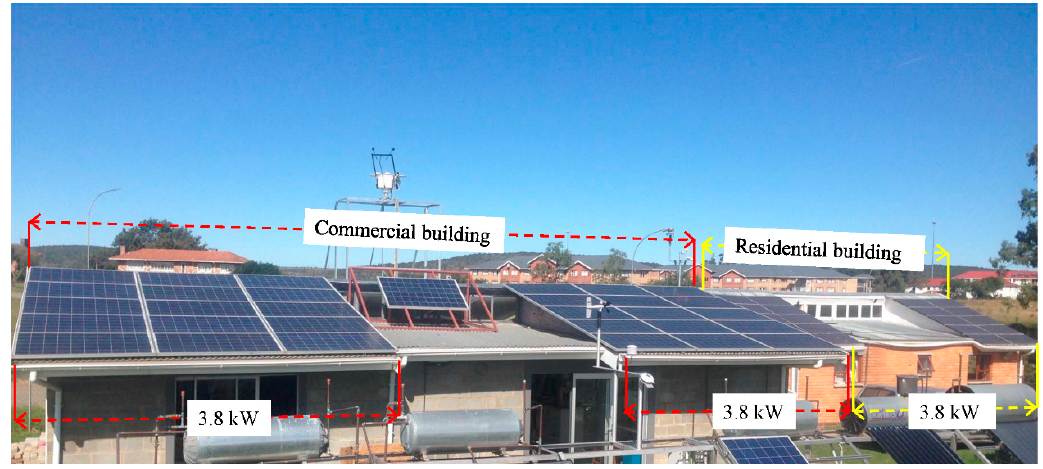
Figure 2. Rooftop mounted PV system in the SolarWatt Park.